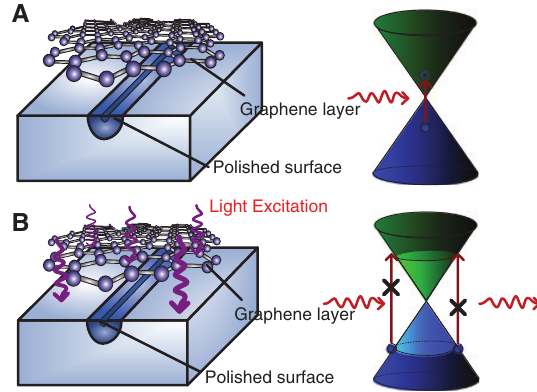
Figure 6: Schematic diagram of photon absorption in graphene (A) with and (B) without intensive light